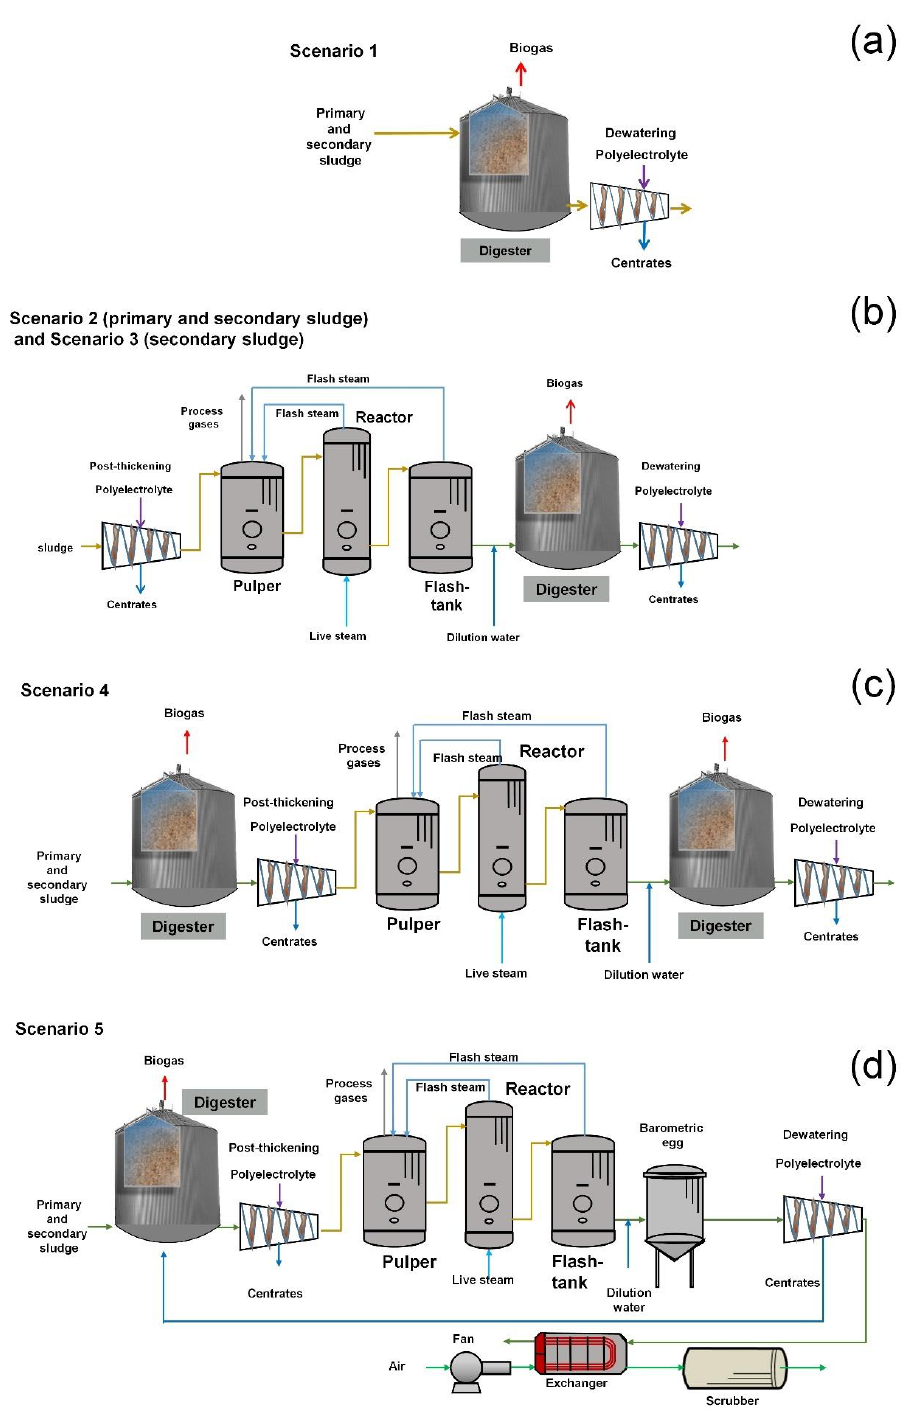
Figure 1. Scheme of the different scenarios. ( a ) Scenario 1: conventional mesophilic digestion process. ( b ) Scenario 2: thermal hydrolysis process (THP) for primary sludge and waste activated sludge (WAS); Scenario 3: THP for WAS. ( c ) Scenario 4: intermediate thermal hydrolysis process (ITHP). ( d ) Scenario 5: the Solidstream ®